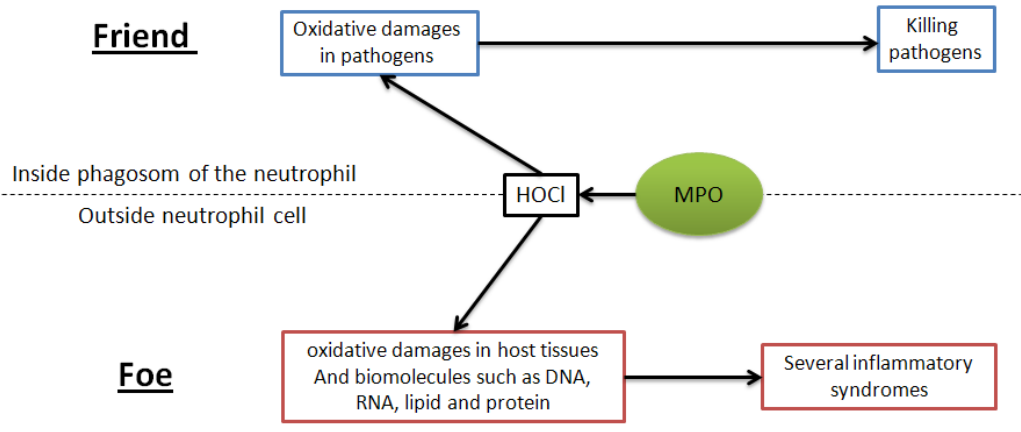
Figure 1. Myeloperoxidase (MPO) plays a critical role in the immune defense system by producing hypochlorous acid (HOCl) which contributes to killing pathogens. However, MPO can be poured out from neutrophils causing oxidative damage to the host